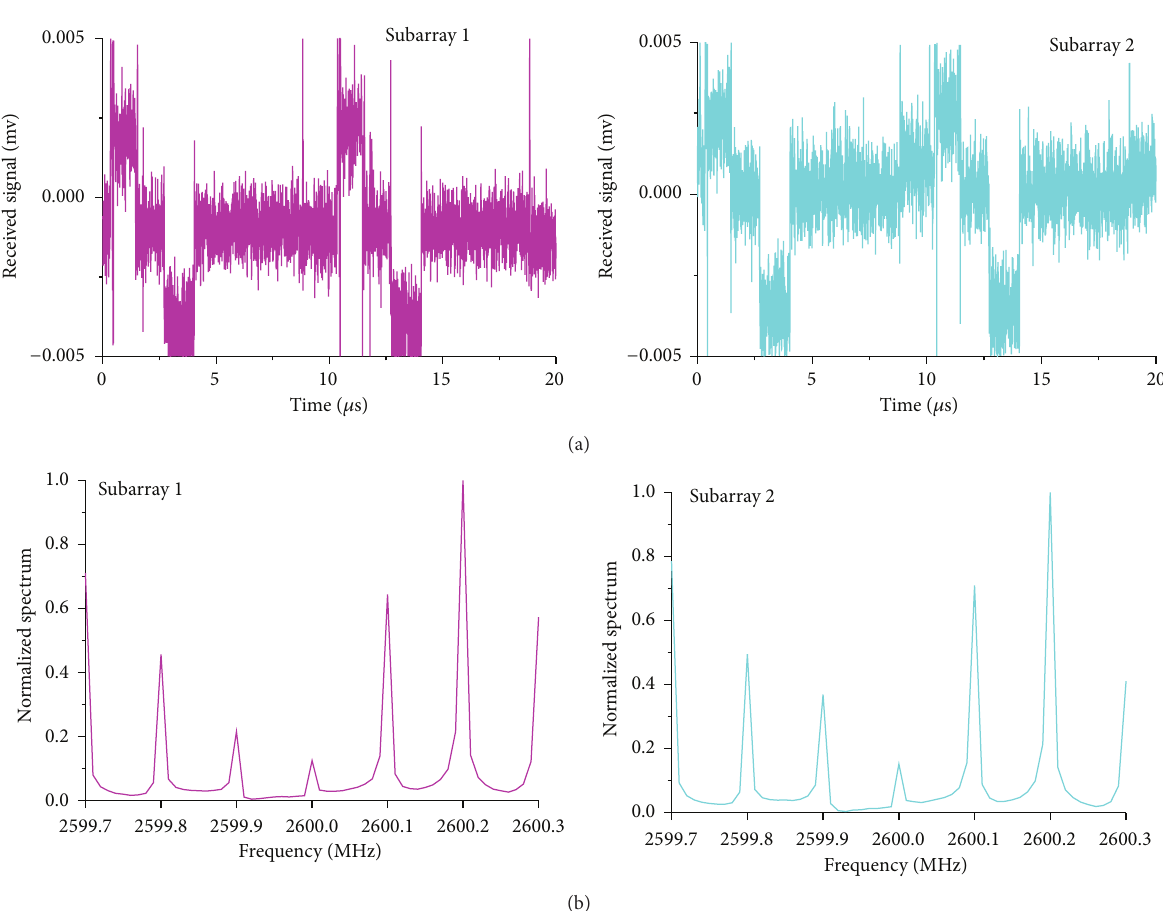
The measurement error for a spatial field of ± 65 ∘ is shown in Figure 16. For the wave coming from the direction of − 60 ∘ to 60 ∘ , the measurement error is less than 2 ∘